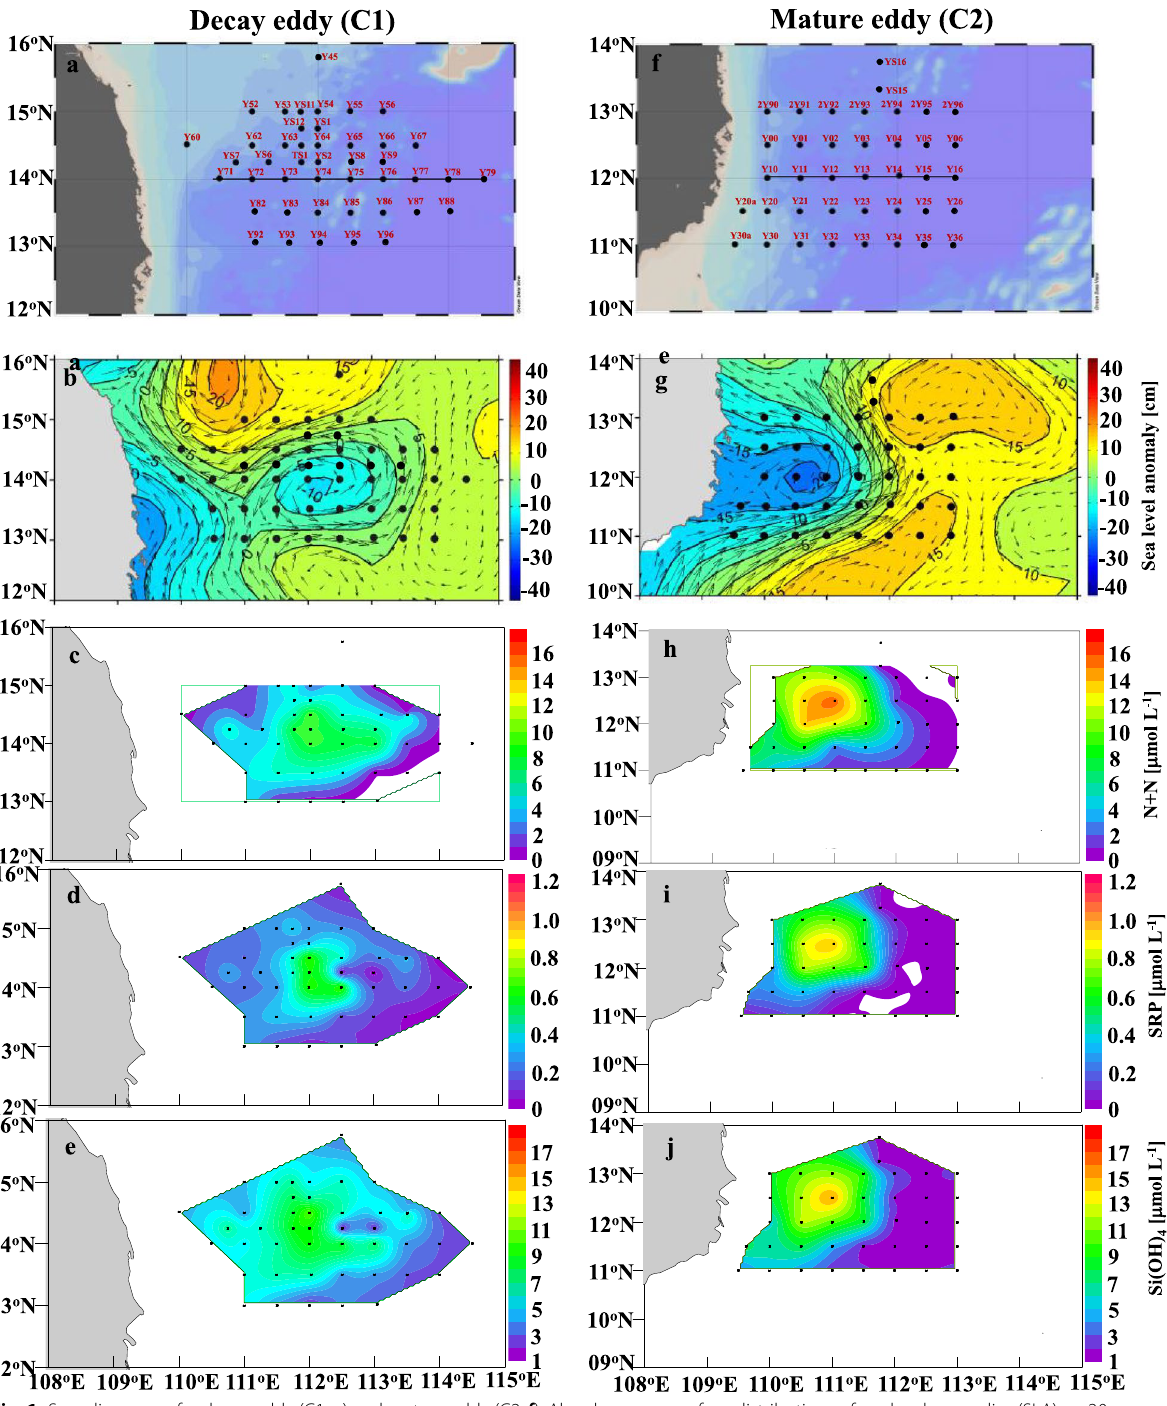
Fig. 1 Sampling maps for decay eddy (C1, a ) and mature eddy (C2, f ). Also shown are surface distributions of sea level anomalies (SLA) on 20 August b for decay eddy and 5 September, 2007 g for mature eddy. Sampling stations for nutrients (black dots) were also superimposed. Surface distributions of N N, SRP and Si(OH) 4 at the depth of 50 m in decay eddy ( c , d , e ) and mature eddy ( h , i , j ). The chosen transects are highlighted in + the sampling maps as black